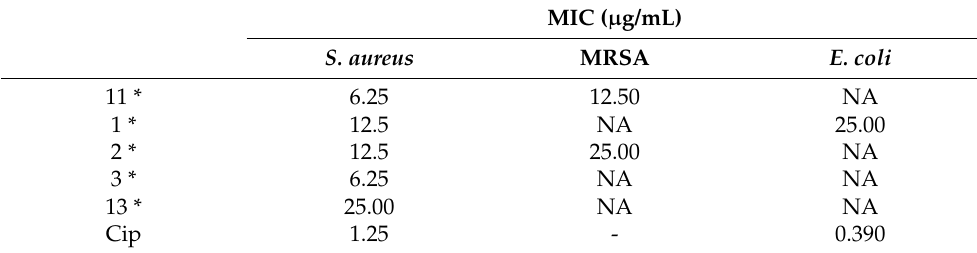
Table 5. Minimum inhibitory concentration (MIC) of DCM Fr purified metabolites.